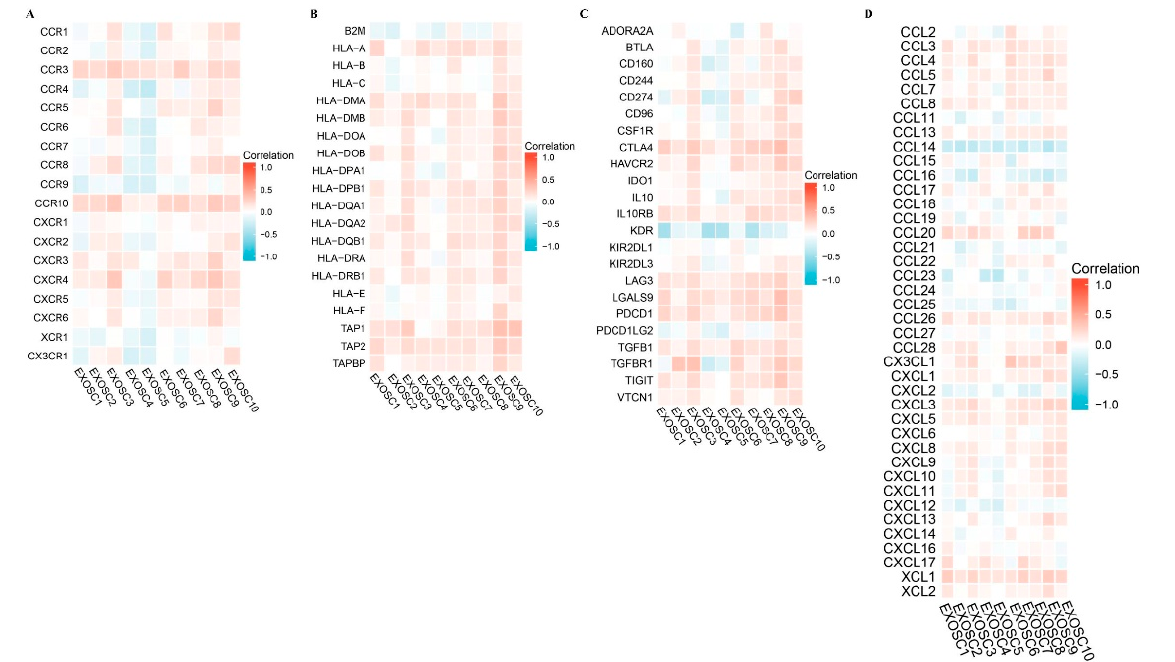
Figure 8. Relationships between the expression levels of EXOSCs and tumor-infiltrating immune cells, immune molecules. The correlation between EXOSCs family expression and, ( A ) immunosuppressive molecules, ( B ) MHC molecule, ( C ) chemokines and ( D ) chemokine receptors in HCC.